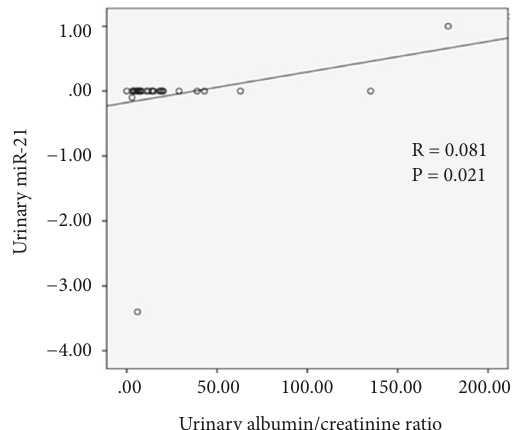
Figure 3: Linear correlation between urinary miR-21 and urinary albumin/creatinine ratio in Fabry disease